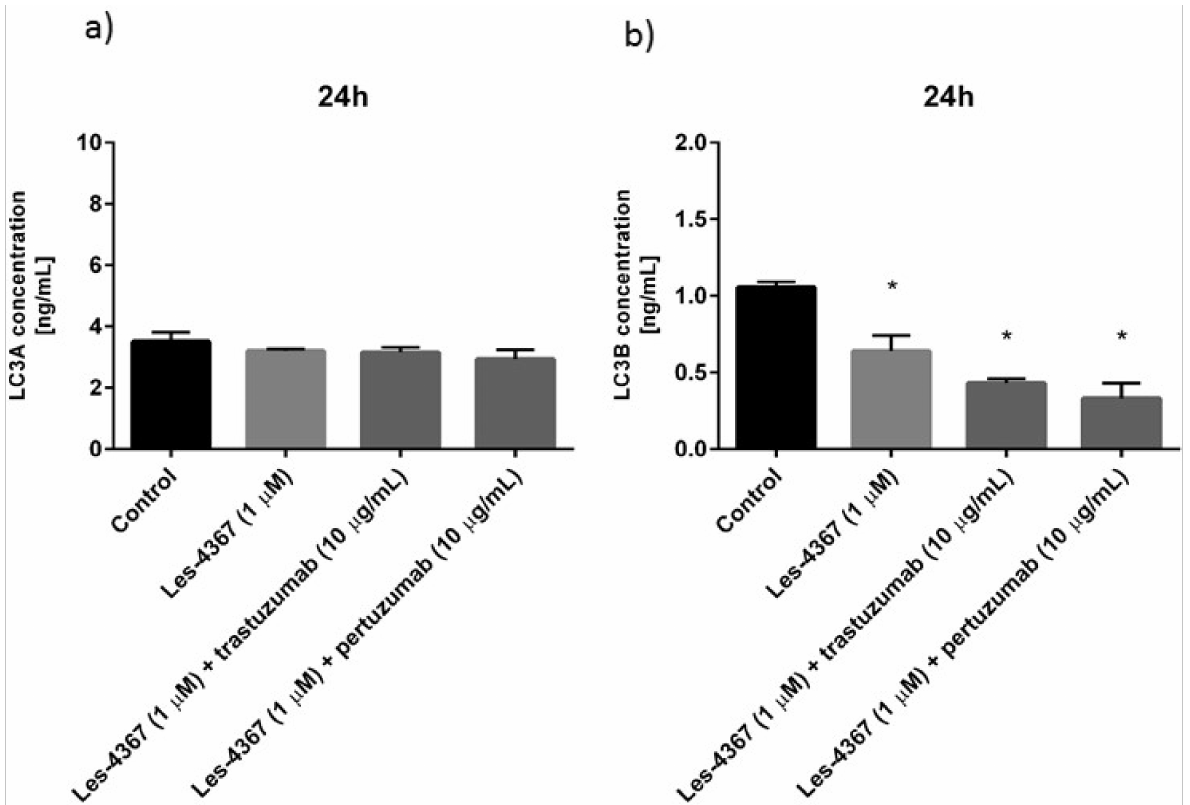
Figure 8. Concentrations of LC3A ( a ) and LC3B ( b ) in AGS cells after 24 h incubation with Les- 4367 (1 µ M) and combined with anti-HER2 antibodies. The ANOVA and Tukey tests were used to demonstrate differences between the control cells and the cells exposed to varying concentrations of the tested compounds. * p ≤ 0.05 vs. control